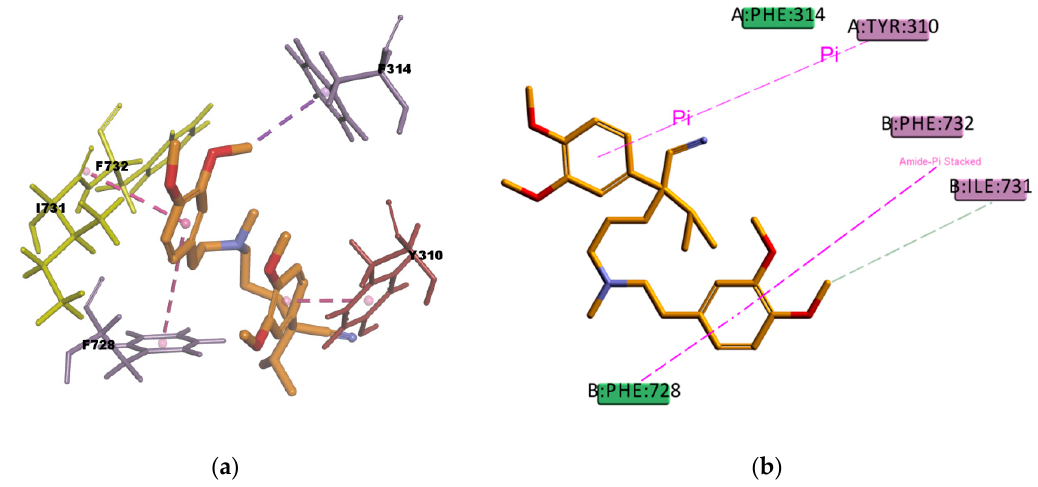
Figure 18. Verapamil (VER) top-ranked pose obtained with CDOCKER algorithm. ( a ) 3D view of VER interactions in the binding pocket. The pink dotted lines represent π – π interactions, and the purple dotted line represents a π –sigma interaction. Residues I731 and F732 involved in the Amide··· π stacking interaction are highlighted in yellow; ( b ) 2D interaction diagram of VER with h P-gp interacting residues. The pink dotted lines represent π interactions, and the light-green line represents a carbon hydrogen bond interaction with residues I731.